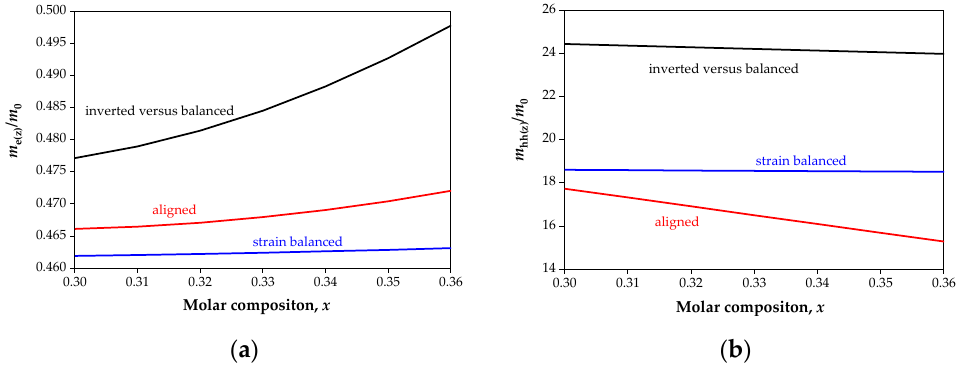
Figure 6. Theoretical simulation of the SL period versus molar composition x with the bandgap energy of 0.22 eV at T = 150 K.